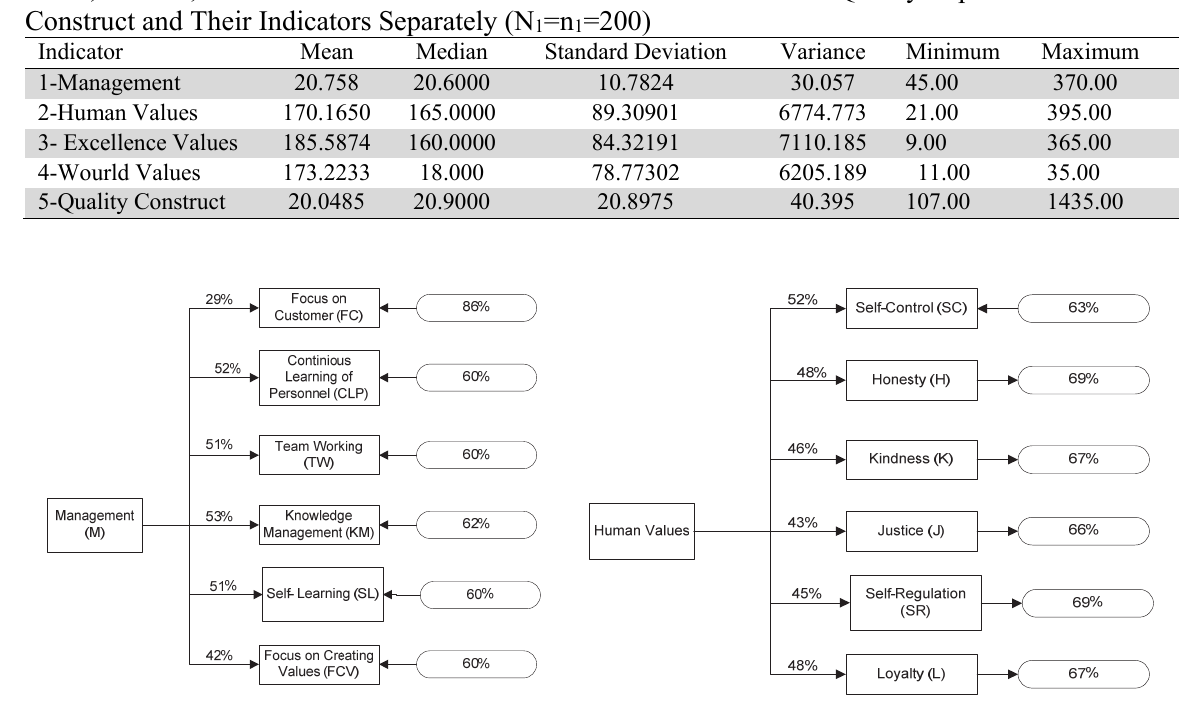
Fig. 7. Factor Analysis Model of hidden variable named Human Values (The second indicator of Quality Improvement in Higher